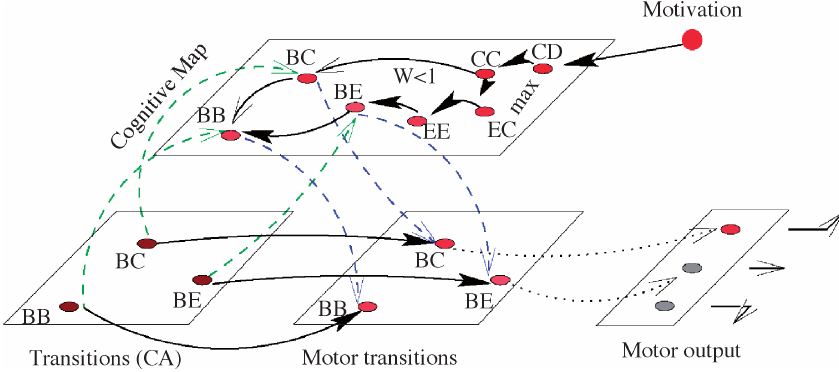
Figure 9. Interaction between the cognitive map and the transitions. Robot is in “B” (transition “BB”). Goal is in “D.” The motivation activates all possible transitions arriving in “D,” here “CD.” This activity diffuses on the cognitive map according to described algorithm. Activity in “BC” is higher than in “BE” or “BB.” In the same time, in CA different transitions from “B” are predicted (“BB,” “BC,” and “BE”). They activate the corresponding motor transitions. The bias coming from the cognitive map enhances “BC” leading to the corresponding motor command.